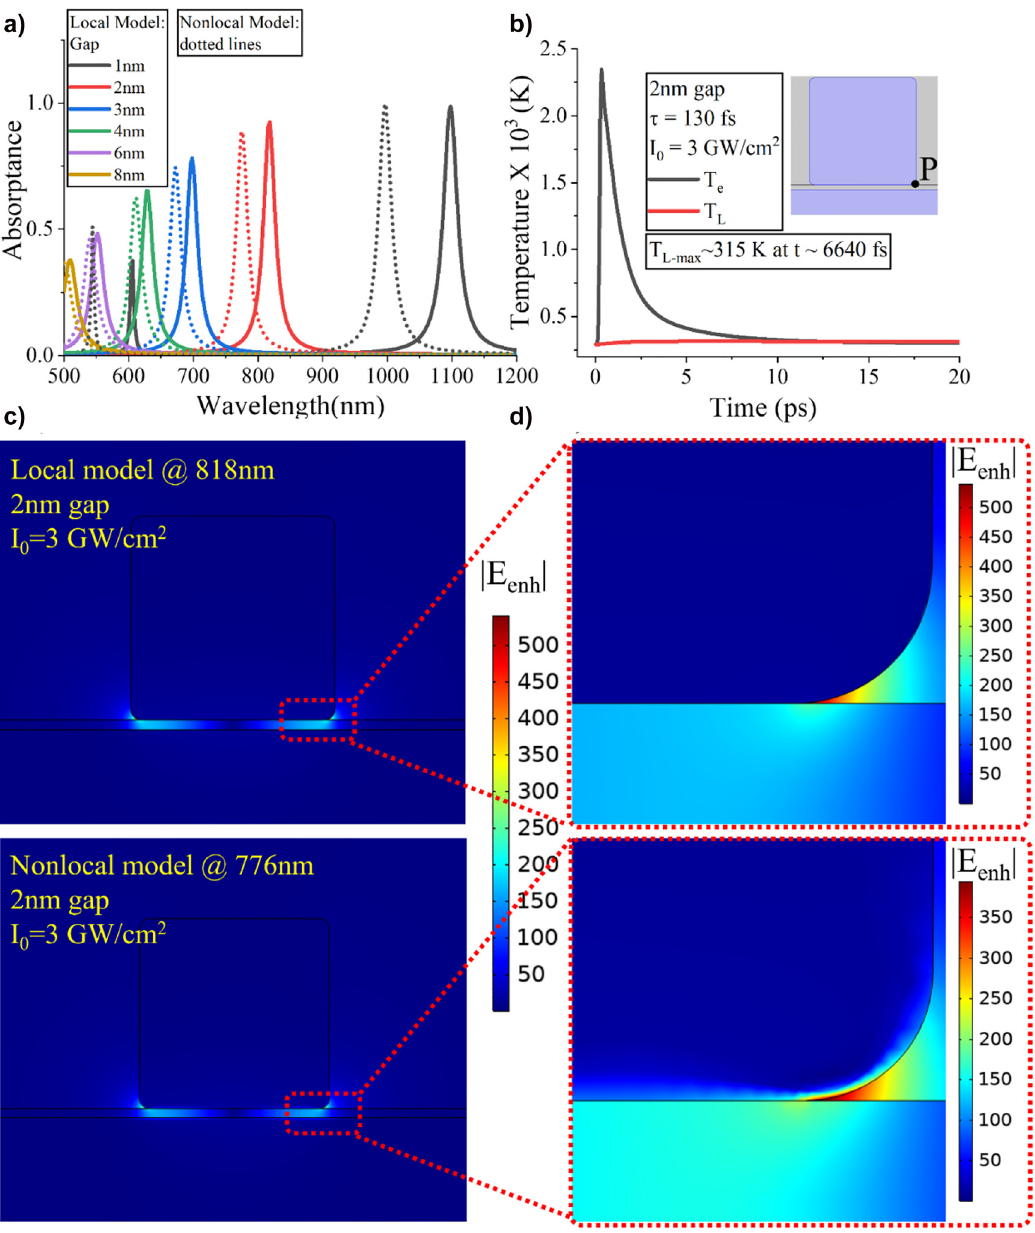
Figure 2: Comparison of the local and nonlocal models. (a) Resonant absorptance spectra for increasing nanogap thicknesses calculated by using the local (solid lines) and nonlocal (dotted lines) simulation models. (b) Electron and lattice temperature dynamics in the case of 2 nm thick nanogap induced by an ultrafast femtosecond laser. The initial room temperature is T 0 = 293 K and the local model is used in these nonequilibrium thermal simulations. Inset: geometry and point P where the temperatures are computed. (c) Electric fi eld enhancement distribution, E enh , forthe same laser conditionsused in(b) derived from local (top panel)and nonlocal (bottompanel)simulationmodels.The colorbaristhesameinthesetwopanels.(d)Magni fi edregionsclosetothenanostripecornerintheresultsshownin(c)butnowusingdifferent colorbar